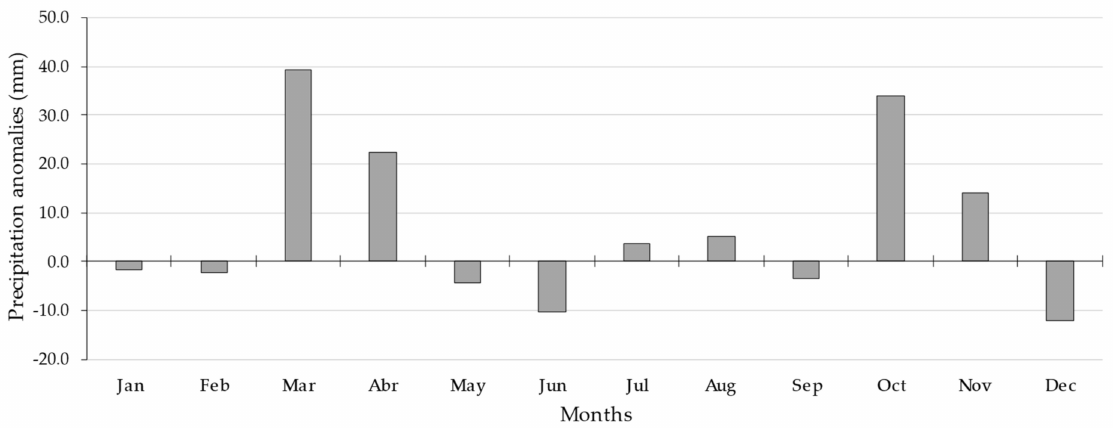
Figure 13. Distribution of monthly mean values for rainfall anomalies in the period of